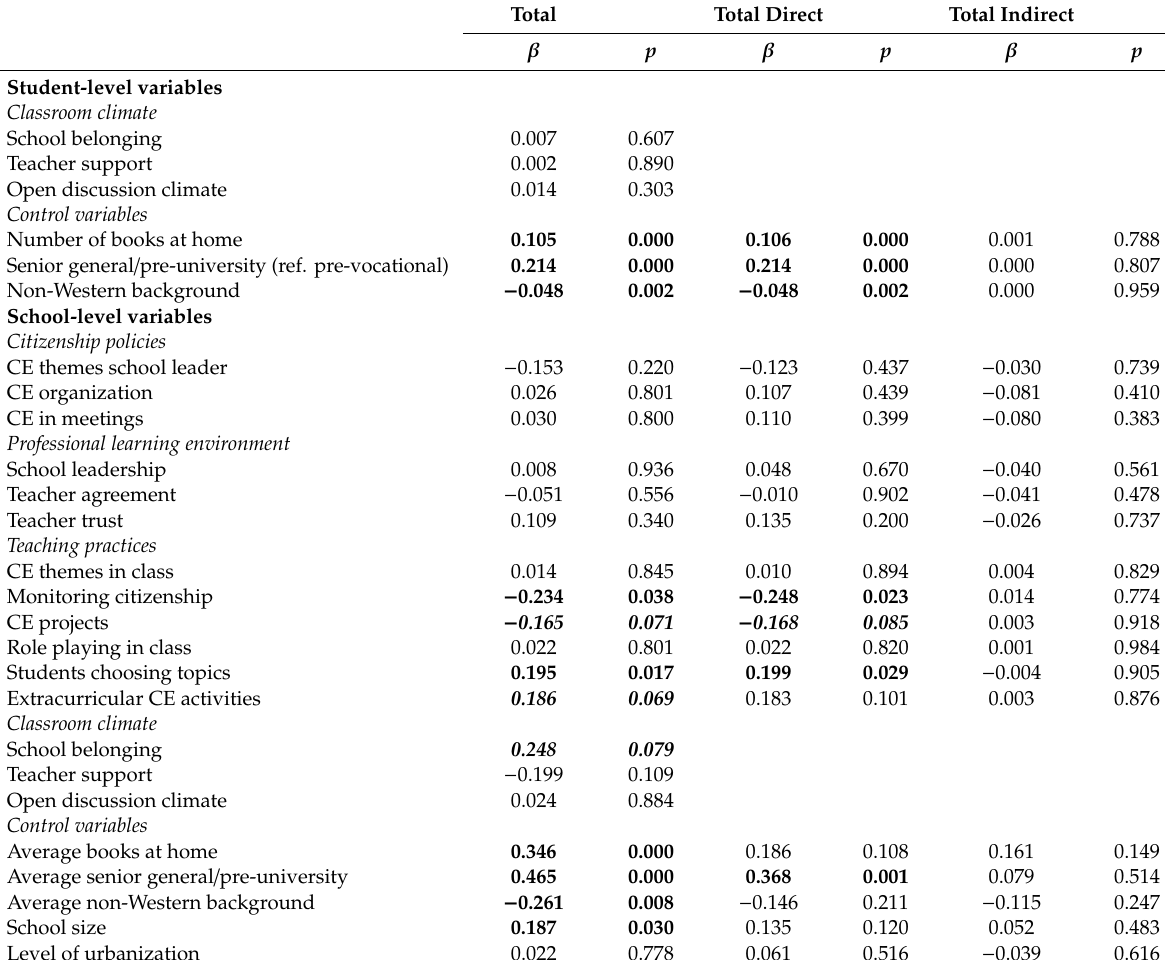
Table 3. Total, direct and indirect e ff ects on citizenship knowledge (standardized